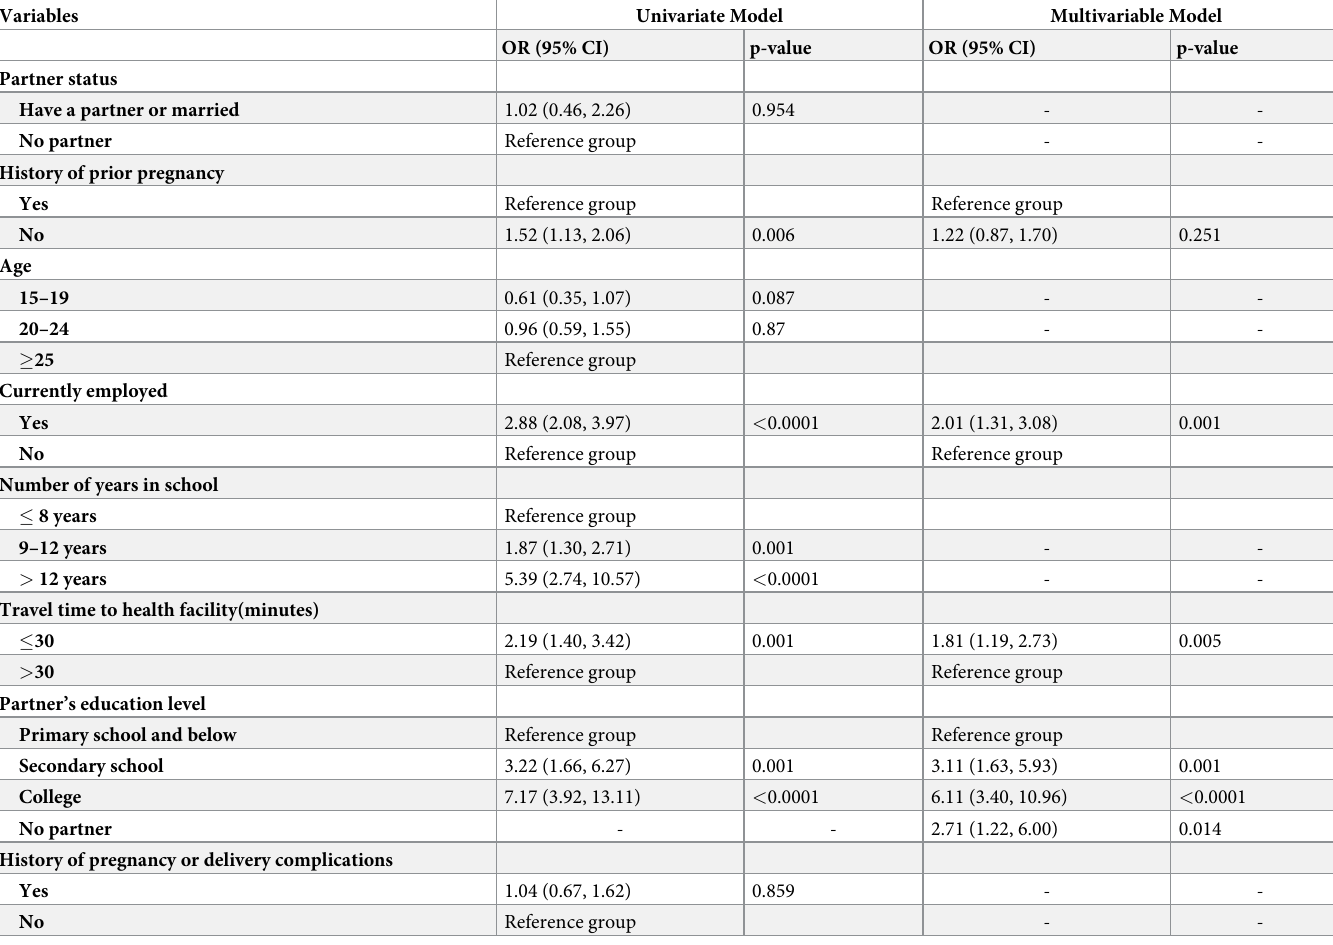
Table 2. Univariate and multivariable logistic regression examining the variables associated with obtaining a pregnancy self-test from a pharmacy.